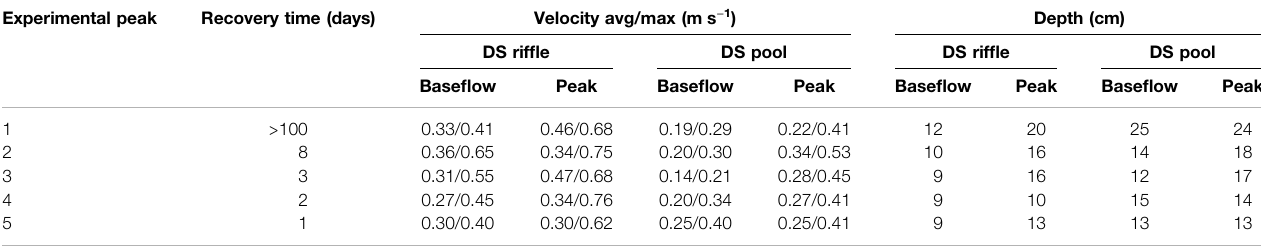
TABLE 2 | Downstream (DS) velocities (m s − 1 ) and depths (cm) recorded for both the downstream rif fl e and the pool, including average and maximum fl ow velocity and during base fl ow (sample 0) and peak fl ow (sample 3). Experimental